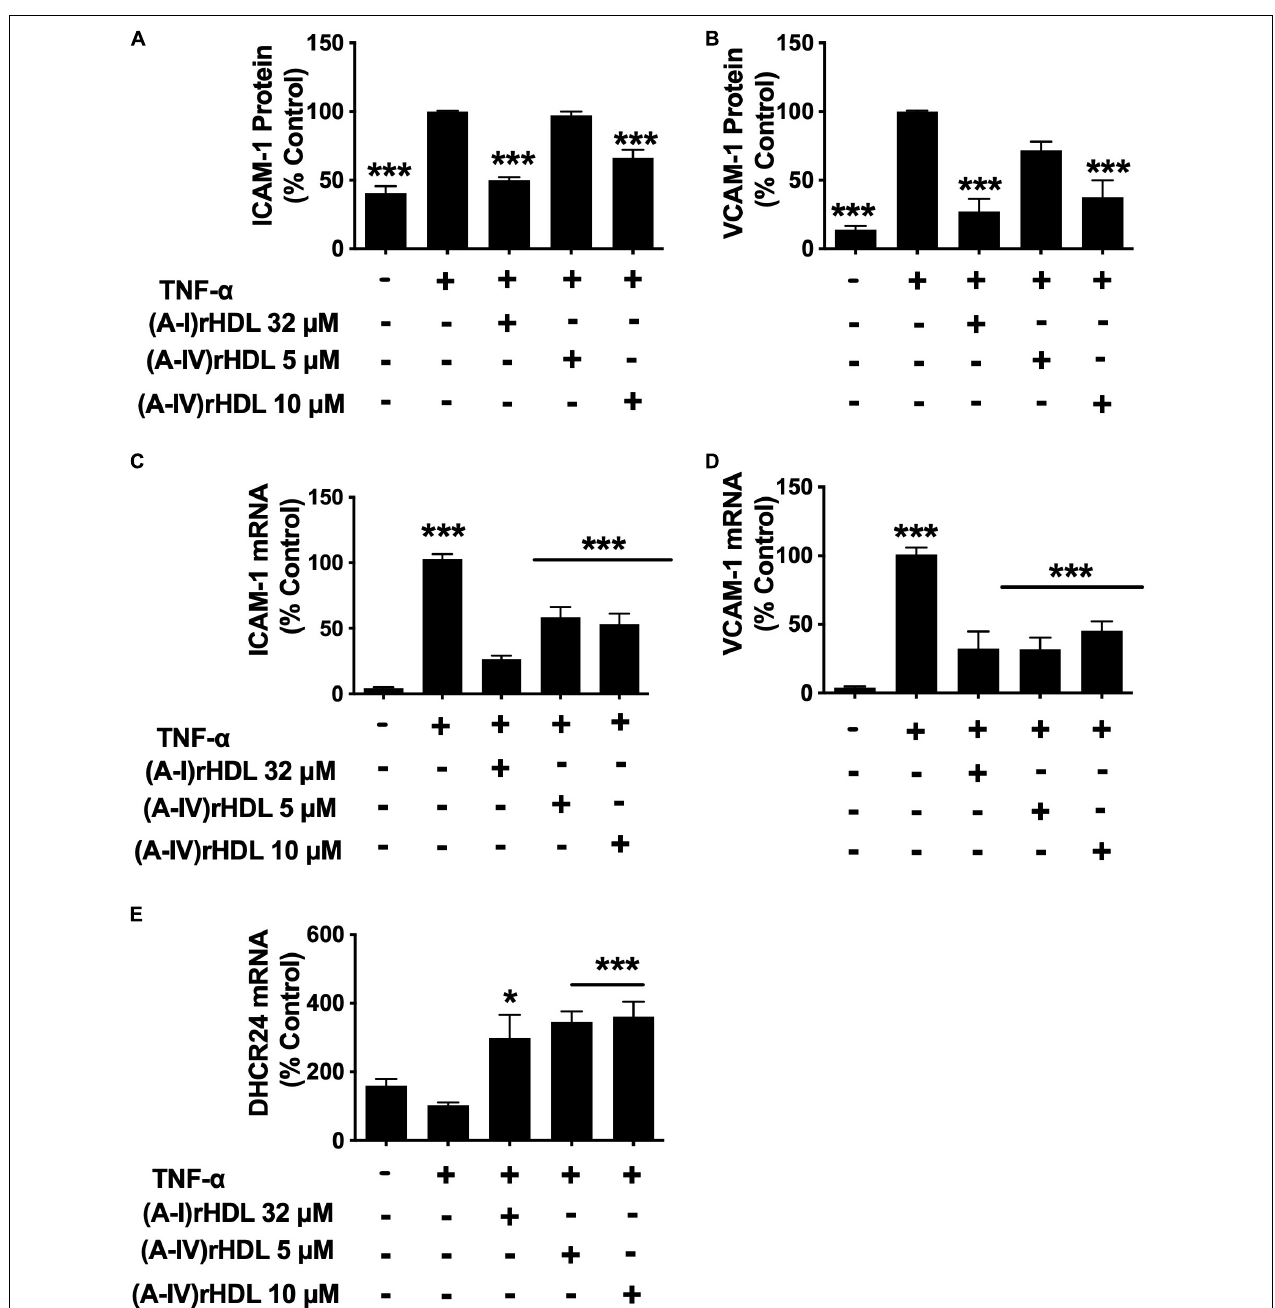
FIGURE 4 | (A-IV)rHDLs inhibit ICAM-1, VCAM-1 expression and increase DHCR24 expression in TNF- α -stimulated HCAECs. HCAECs were incubated for 16 h with (A-I)rHDLs (final apoA-I concentration 32 µ M) and (A-IV)rHDLs (final apoA-IV concentrations 5 and 10 µ M). The rHDLs were then removed and the cells were incubated for a further 5 h with TNF- α (final concentration 0.2 ng/mL). ICAM-1 [Panel (A) ] and VCAM-1 [Panel (B) ] protein expression was quantified by flow cytometry. ICAM-1 [Panel (C) ], VCAM-1 [Panel (D) ], and DHCR24 [Panel (E) ] mRNA levels were quantified by qPCR. The mean ± SEM of three independent experiments, each performed in triplicate are shown. * p < 0.05, *** p <